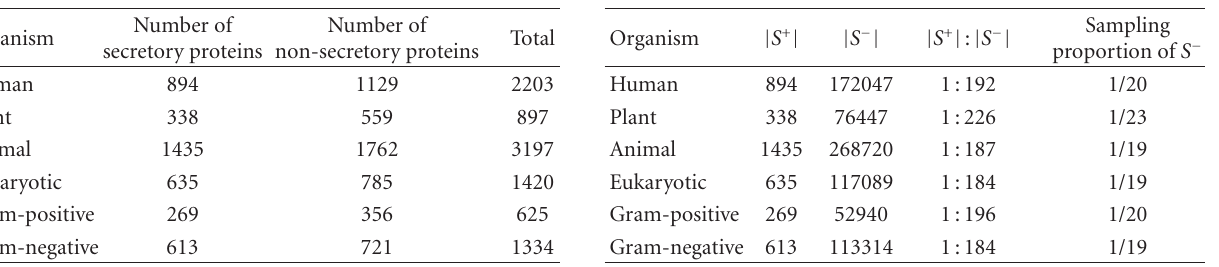
Table 1: Number of the secretory and nonsecretory proteins in each of the six di ff erent organism datasets.